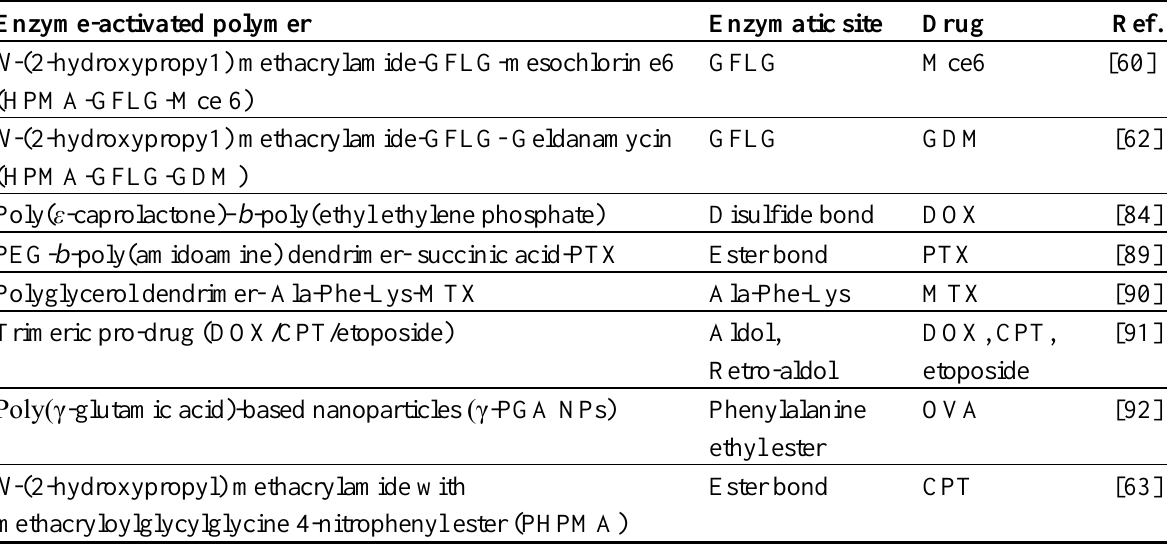
Table 2. Examples of enzymatically responsive